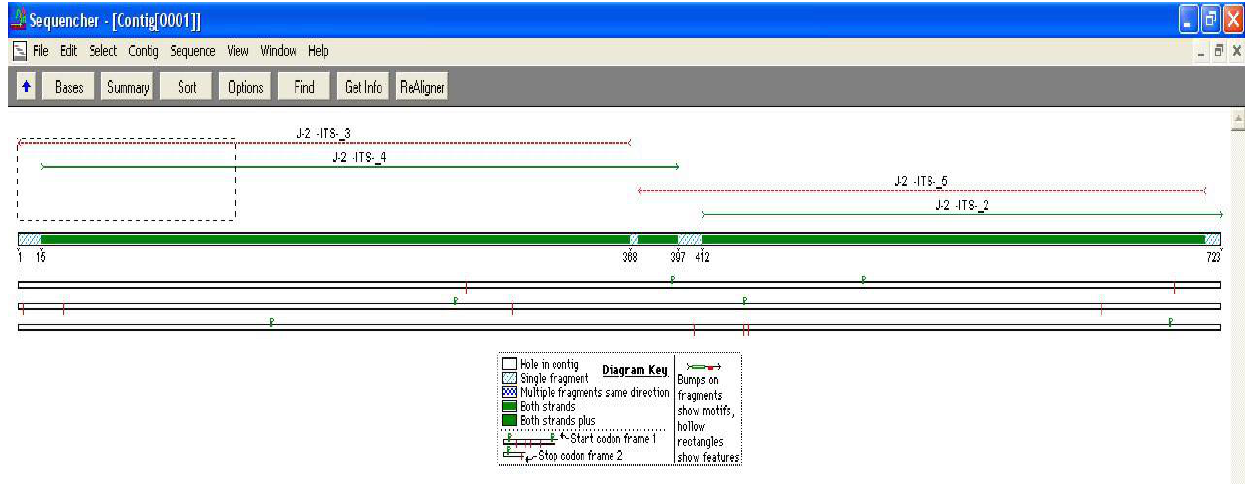
Supplementary Data 1. Screenshot showing complete sequence assembly of ITS region obtained with four